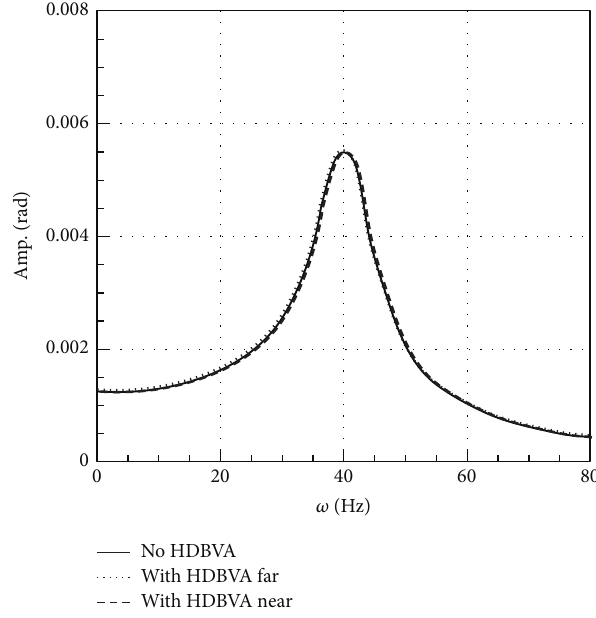
Figure 6: Numerical results of frequency response in 𝑍 𝑍 DOF with lateral groove.